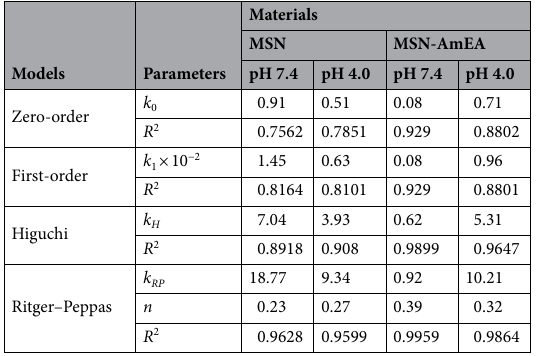
Table 2. The result of fitting the quercetin release data with the zero-order, first-order, Higuchi and Ritger– Peppas models.